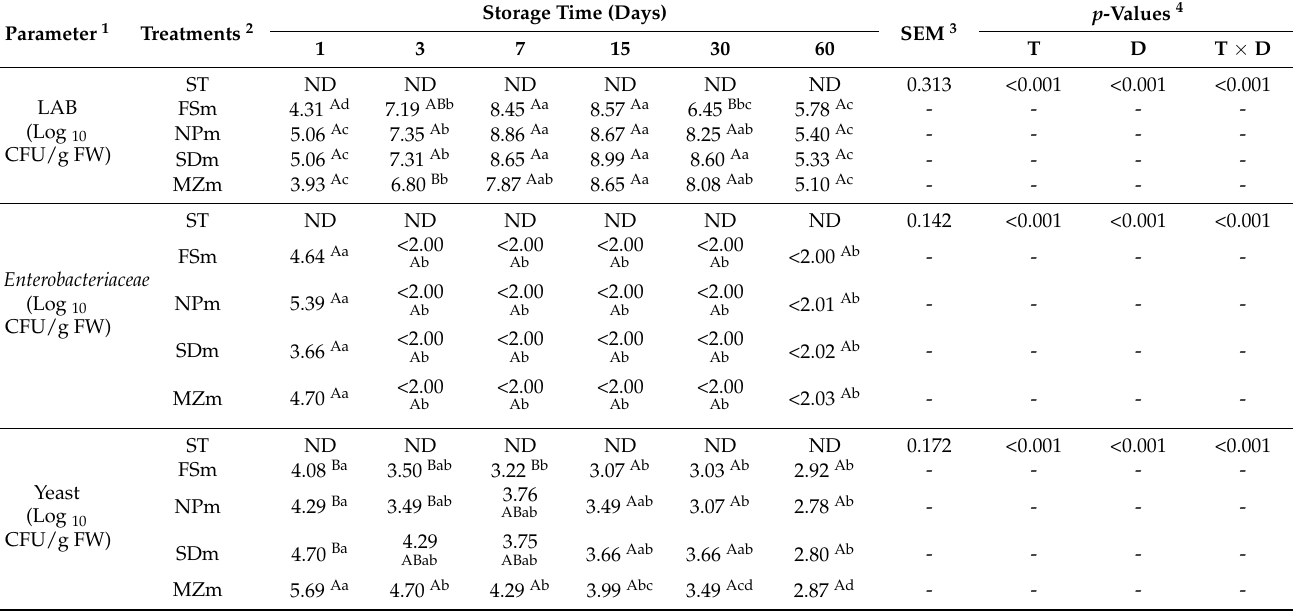
Table 5. Dynamics of microbial composition during 60 days ensiling of forage sorghum